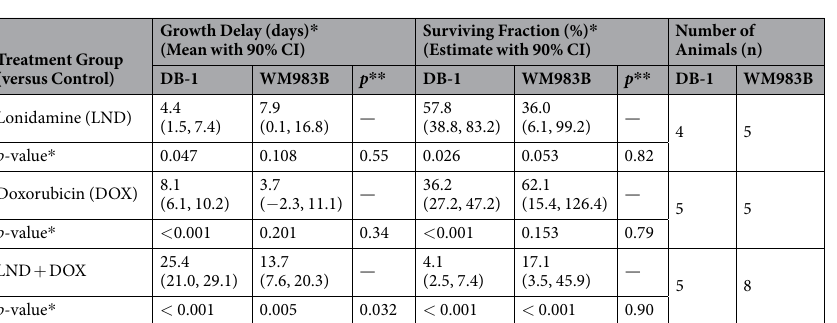
Table 2. Lonidamine (LND) induces a lesser potentiation to doxorubicin (DOX) in WM983B human melanoma xenografts compared to DB-1 human melanoma xenografts. We show estimated growth delay (T- C), doubling time (T d ), and surviving fraction as percent by treatment arm in WM983B and DB-1 xenografts following LND administration. The data for DB-1 were re-analyzed from a previous publication in order to be comparable to the analysis for WM983B 14 . In the control, doubling times were 5.52 days for DB-1 and 5.38 days for WM983B. * p -value for one-sided test comparing each treatment group to control ** Two-sided p -value comparing the two cell